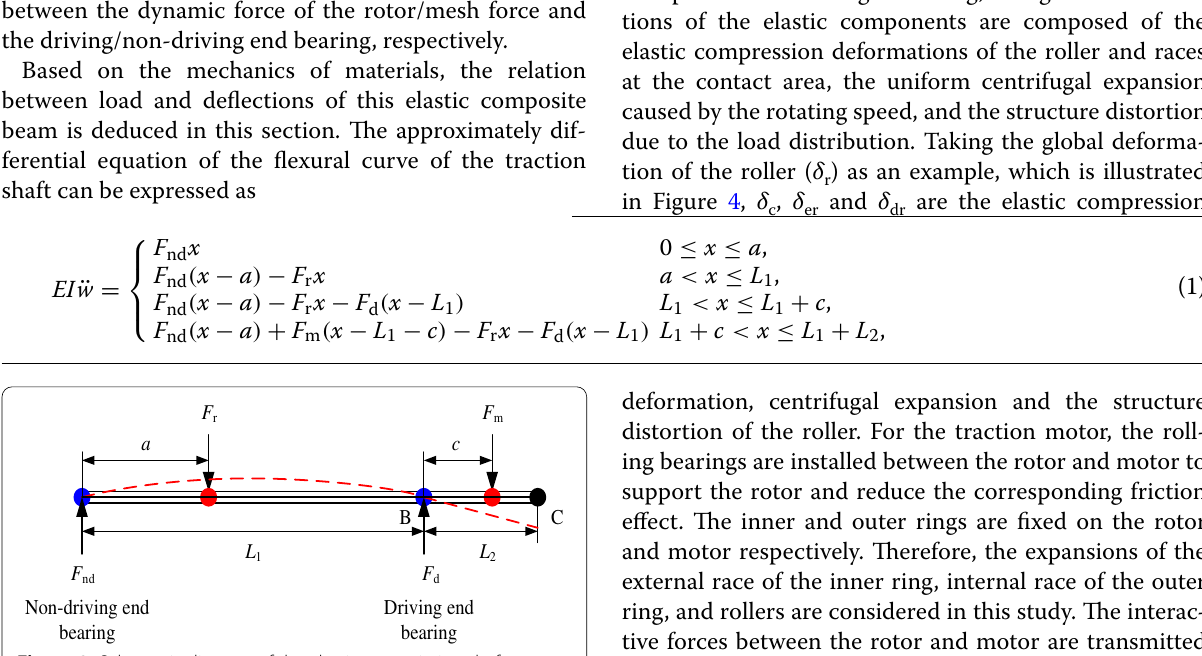
Figure 3 Schematic diagram of the elastic transmission